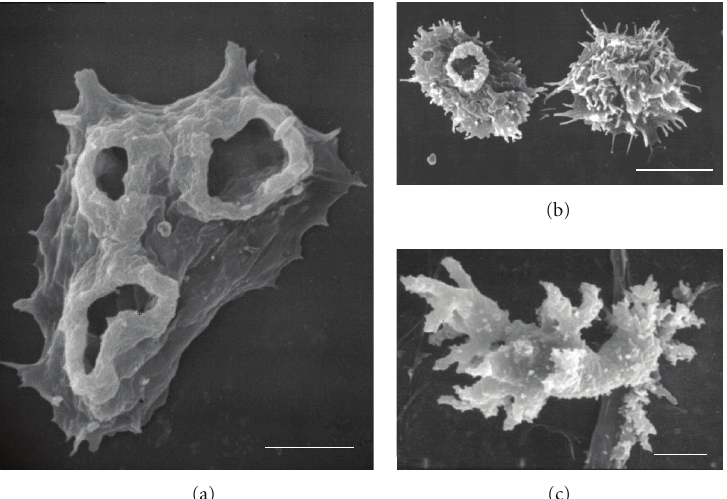
Figure 1: Fine morphology of trophozoites of N. fowleri, (a) Acanthamoeba spp. , (b) and B. mandrillaris , (c) by Scanning Electron Microscopy. Bars represent 5 µ